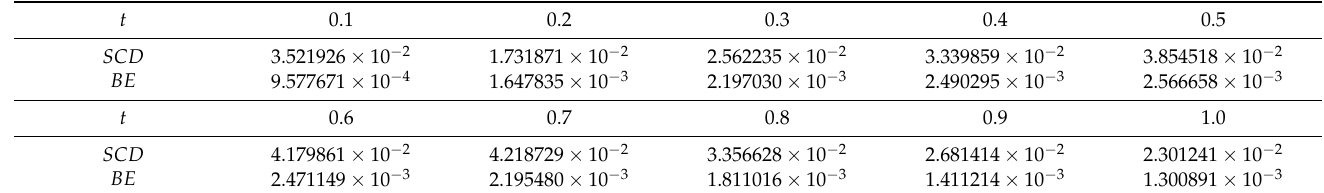
Table 8. Wave equation of Example 6: Maximum absolute error E ∞ at some time nodes, where ∆ t = 0.01, where the second order central difference scheme (SCD) and the backward Euler scheme (BE) are applied,